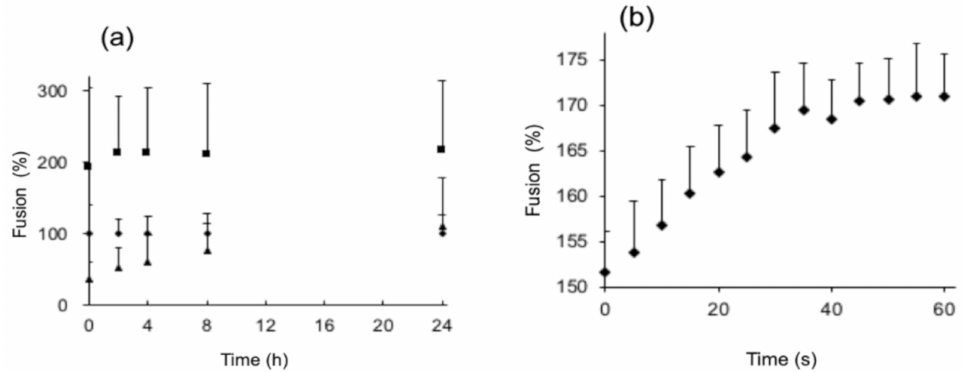
Figure 2. Fusion rate of stratum corneum lipid liposomes (SCLLs) with stratum corneum lipid liposomes, DMPC liposomes and MEL-B liposomes. ( a ) Results up to 24 h; ( b ) only MEL-B liposomes (60 s). Symbols: closed diamond, SCLLs / SCLLs; closed triangle, DMPC liposomes / SCLLs; closed square, MEL-B liposomes / SCLLs. Values are expressed as the mean ± S.D. of three